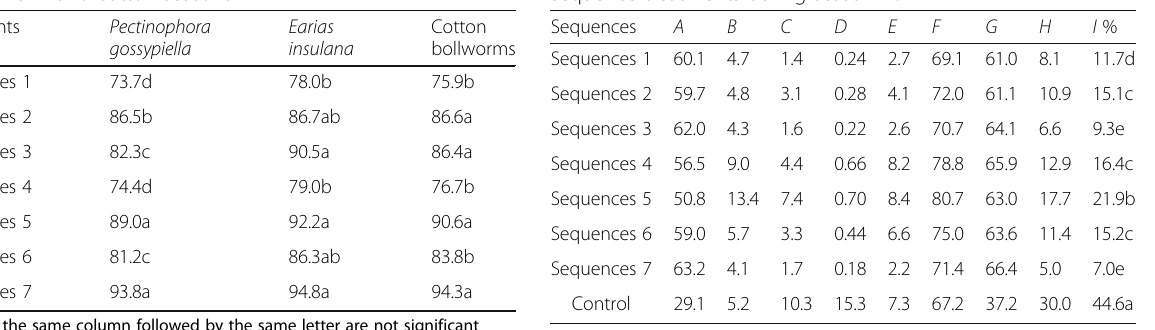
Table 5 Average of infestation reduction percentage for bollworms in two cotton seasons